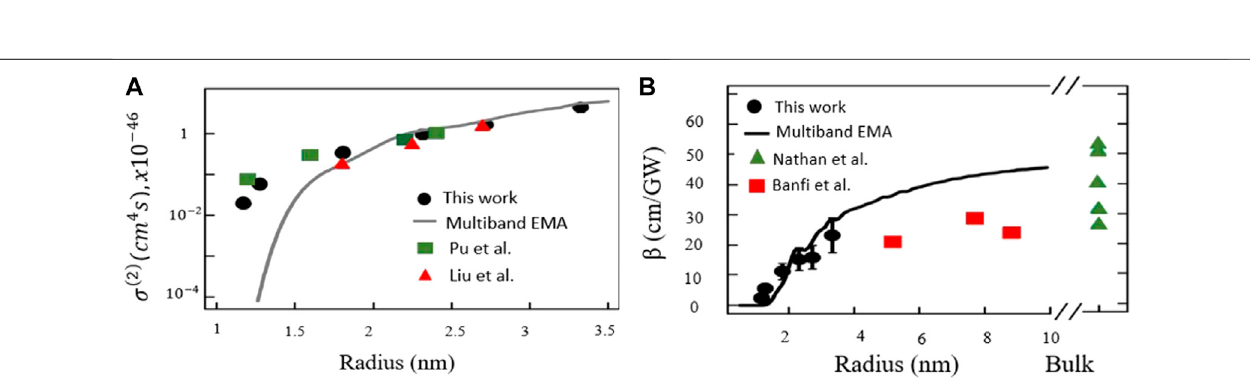
FIGURE 11 | (A) Two-photon absorption cross-section σ ( 2 ) dependence on CdSe QD radius at 800 nm: simulation based on a multiband EMA (solid line) and experimental values (black circles). Earlier studies results from Pu et al. [130] (green square) and Liu et al. [131] (red triangles) were included for comparison. (B) Two- photon absorption cross-section β dependence on CdSe QD radius at 800 nm: experimental values (black circles), simulation (solid line). Earlier studies result from Ref. [132] on CdS x Se 1 − x nanocrystals in glass and (red square) and from Ref. [133] β for bulk CdSe at 800 nm (green triangles) were included for